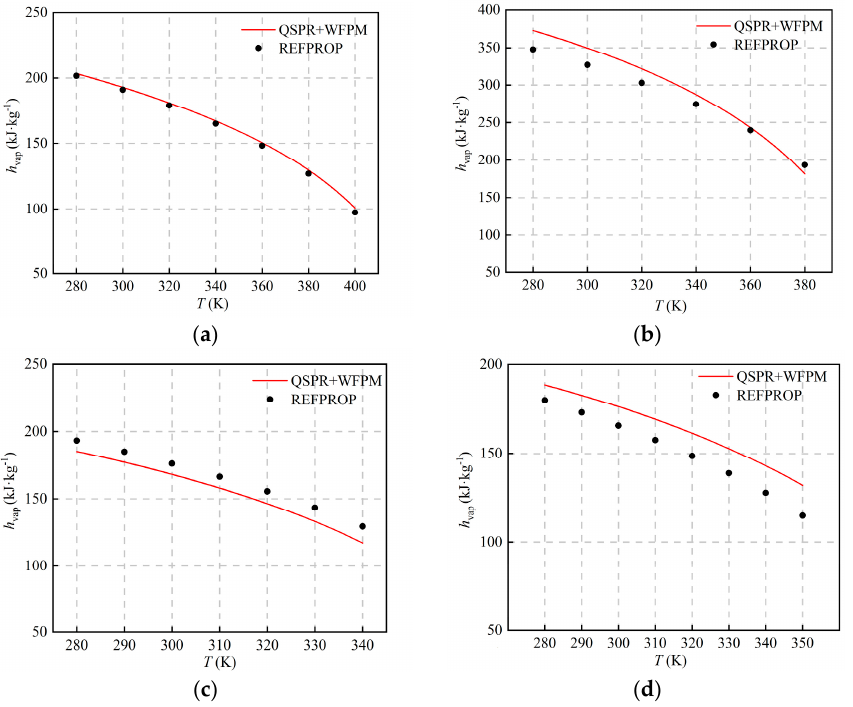
Figure 5. Comparison of h vap at different temperatures: ( a ) R245fa; ( b ) R600a; ( c ) R134a; ( d ) R1234ze(E).